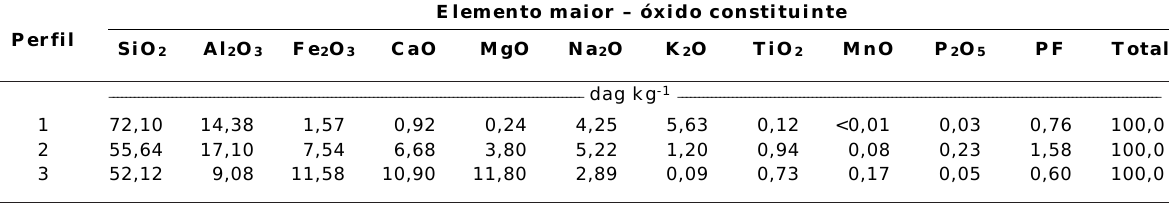
(1) PVAd = Argissolo Vermelho-Amarelo distrófico: Granito. (2) PVe = Argissolo Vermelho eutrófico: Diorito milonítico. (3) MTf = Chernossolo Argilúvico férrico: Piroxenito granulitizado.